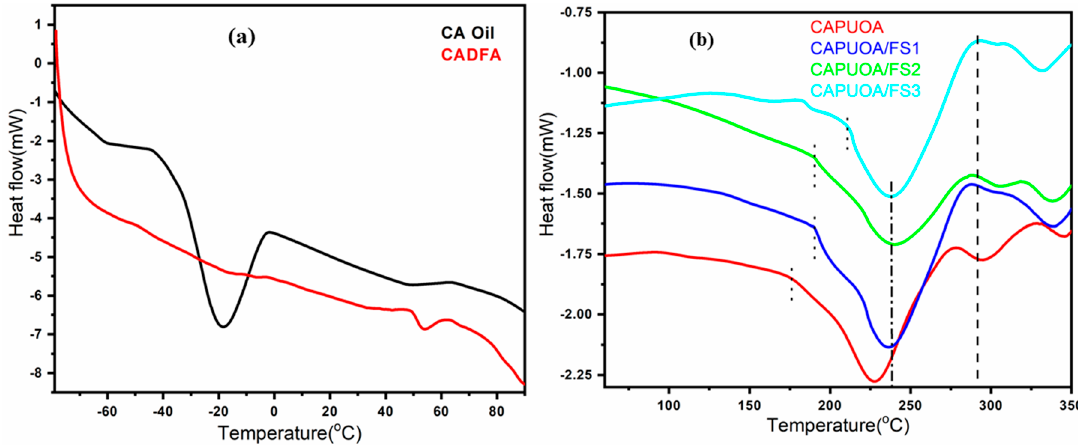
Figure 8. DSC of CA oil and CADFA ( a ) and CAPUOA, CAPUOA/FS1, CAPUOA/FS2, and CAPUOA/FS3 ( b ).